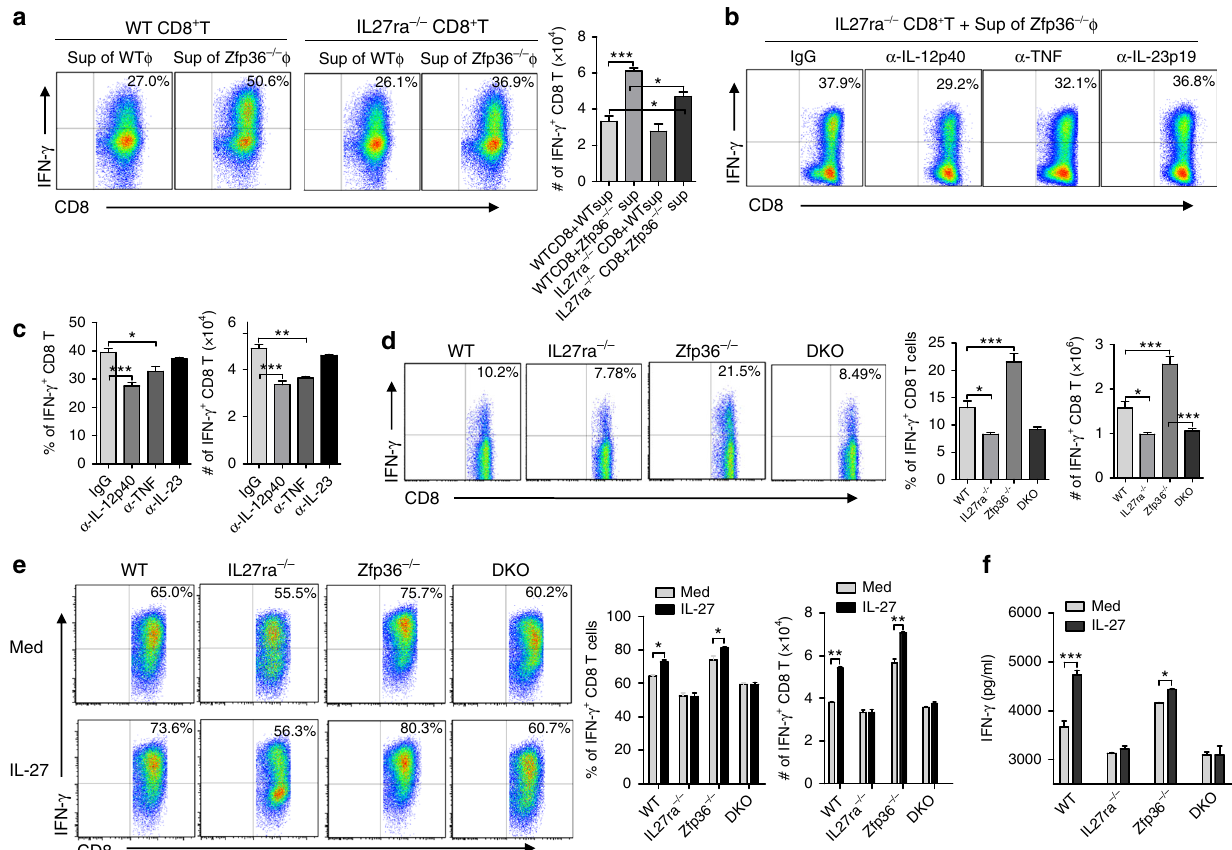
Fig. 5 IL-27 derived from Zfp36 − / − macrophages enhances IFN- γ production by CD8+ T-cells. a WT and Zfp36 − / − peritoneal macrophages were stimulated by LPS (1 μ g/ml) for 24 h, and then supernatants were collected. Puri fi ed naive WT and IL27ra − / − CD8 + T-cells were cultured with the supernatants (1:1) in the presence of plate-coated α -CD3/CD28 Abs (1 μ g/ml) for 3 days. IFN- γ + CD8 + T-cells were detected by FACS. Quantitative data shown are means ± s.d. from three independent experiments. b , c Supernatants of the above Zfp36 − / − peritoneal macrophages were respectively pre-treated with neutralizing antibodies against IL-12 p40, TNF and IL-23 p19 (10 μ g/ml) for 30 min, then cultured with IL27ra − / − naive CD8 T-cells as in a . IFN- γ + CD8 + T-cells were detected by FCM. Quantitative data shown are means ± s.d. from three independent experiments. d Splenocytes isolated from WT, IL27ra − / − , Zfp36 − / − and IL27ra − / − Zfp36 − / − double KO (DKO) mice were stimulated by PMA and Ionomycin with GolgiStop for 4 h. IFN- γ + cells were detected by FACS, gated on CD3 + CD8 + double positive cells. Quantitative data represent means ± s.d. from three mice of each group. e Splenocytes of WT, IL27ra − / − , Zfp36 − / − and DKO mice were stimulated by soluble α -CD3/CD28 Abs (1 μ g/ml) in the presence or absence of IL-27 (2 ng/ml) for 3 days. Then IFN- γ + CD8 + T-cells were detected by FCM. Quantitative data represent means ± s.d. from three independent experiments. f IFN- γ levels in the supernatants as in e were detected by ELISA. Data were analyzed with one-way ANOVA (Nonparametric) with Tukey (compare all pairs of columns), * p < 0.05; ** p < 0.01; *** p < 0.001. Φ